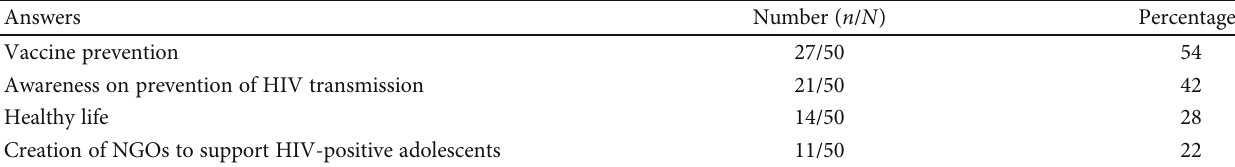
Table 3: Distribution of respondents according to the suggestions relating to the prevention of the transmission of HIV AIDS ( N = 50 ).